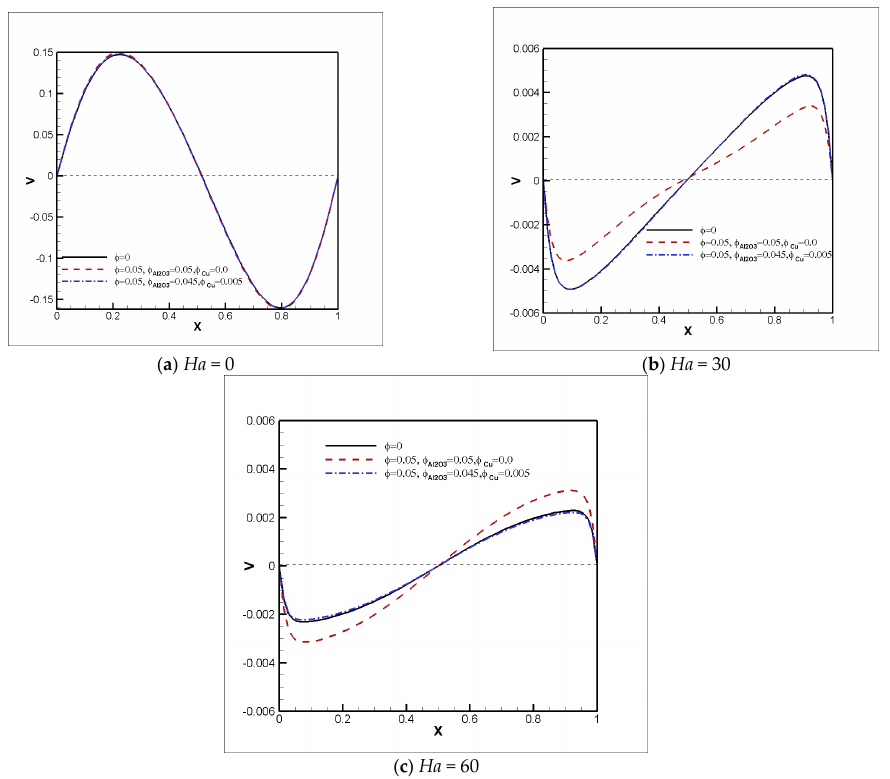
Figure 9. Local Nusselt number profiles versus X -axis for Ri = 1 and various Hartmann numbers and solid volume fractions.